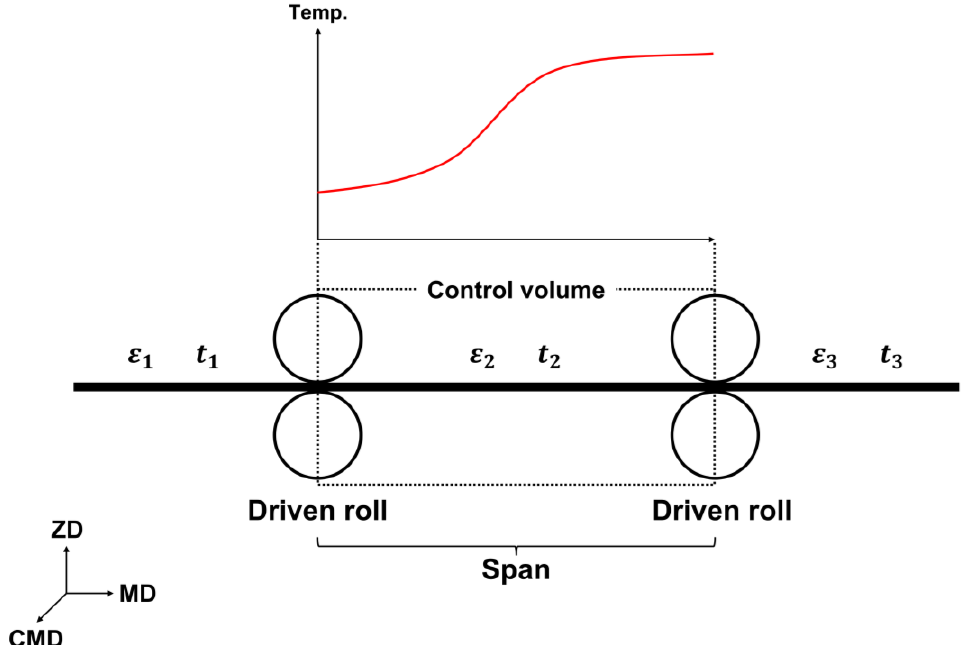
Figure 1. Schematic of span with web temperature variations. Note: ZD, z-direction; MD, machine direction; CMD, cross-machine direction, 𝜀 1 , 𝜀 2 , 𝜀 3 , strain of web at each span; 𝑡 1 , 𝑡 2 , 𝑡 3 , tension direction; CMD, cross-machine direction, ε 1 , ε 2 , ε 3 , strain of web at each span; t 1 , t 2 , t 3 , tension of of web at each span. web at each